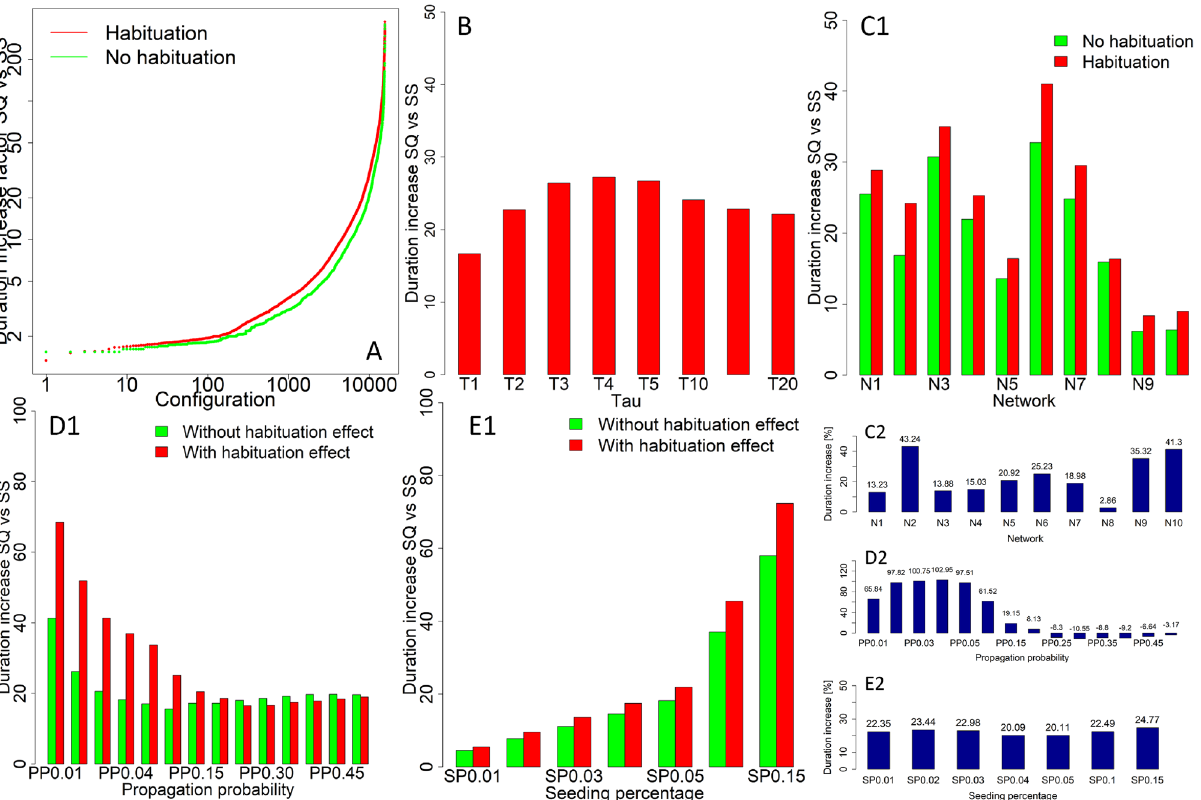
Figure 3. ( A ) Duration increase for processes initialised by sequential seeding, when compared to single-stage seeding, for configurations with and without habituation effect (sorted by increase). ( B ) Duration increase for processes initialised by sequential seeding, when compared to single-stage seeding, for τ ranging from 1 to 20. ( C1 ) Duration increase for processes initialised by sequential seeding, when compared to single-stage seeding, for Networks N1–N10 with habituation and non-habituation setups. ( C1 ) Percentage representation of duration increase for Networks N1–N10. ( D1 ) Duration increase for processes initialised by sequential seeding, when compared to single-stage seeding, for propagation probabilities ranging from PP = 0.01 to PP = 0.5 , with or without the habituation effect. ( D2 ) Percentage representation of duration increase for propagation probabilities ranging from PP = 0.01 to PP = 0.5 . ( E1 ) Duration increase for processes initialised by sequential seeding, when compared to single-stage seeding, for seeding percentages ranging from SP = 0.01 to SP = 0.15 , with and without the habituation effect. ( D2 ) Percentage representation of duration increase for seeding percentages ranging from SP = 0.01 to SP = 0.15